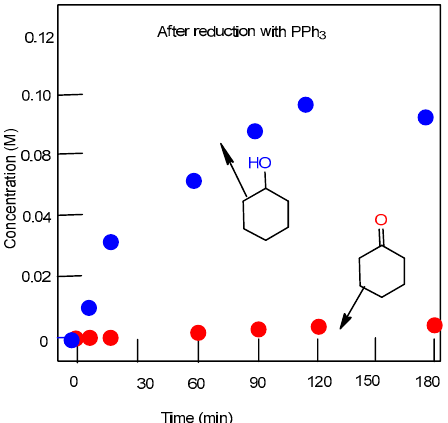
Figure 3. Accumulation of cyclohexanol and cyclohexanone in the oxidation of cyclohexane (0.46 M) with H 2 O 2 (2.0 M) catalyzed by complex 1 (5 × 10 − 4 M) in the absence of PCA, at 50 ◦ C in acetonitrile. Concentrations of products were measured by GC after the reduction of the reaction samples with solid PPh 3.